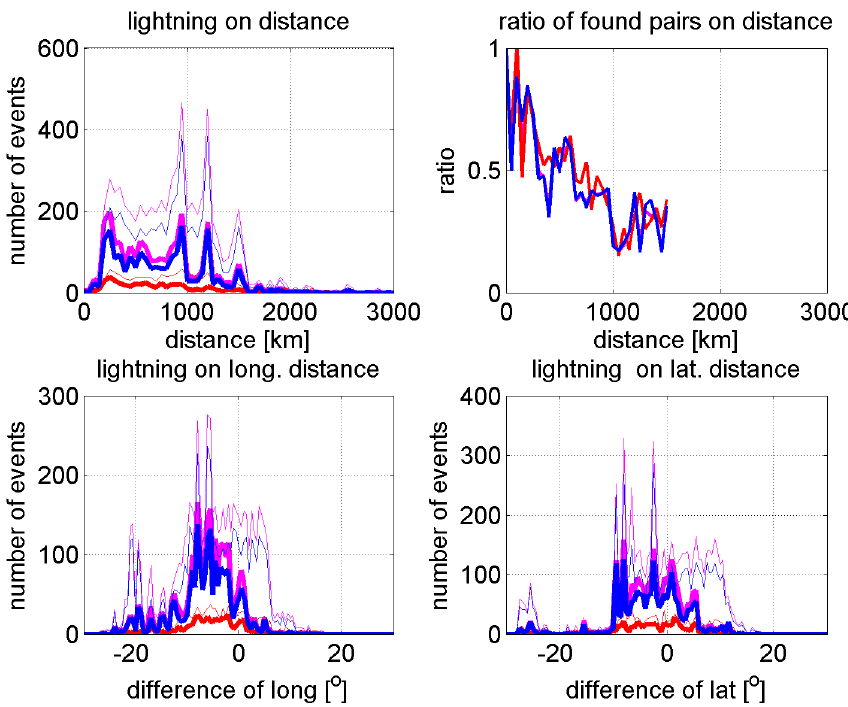
Fig. 6. Top left plot: occurrence histograms of lightning discharges on distance from the magnetic footprints of the satellites. Thick lines stand for the lightning for which the corresponding whistler was found, thin lines stand for all detected lightning. Magenta lines represent all types of discharges, blue − CG discharges, red +CG discharges. Top right plot: the ratio of lightning discharges for which the corresponding whistler was found to all discharges. Colours distinguish different types of discharges and their meaning is the same as in the top left plot. Note that the values for distances larger than ∼ 1500km are statistically insignificant – see the top left plot. Bottom: Occurrence histogram of the distances between the magnetic footprints of the satellites and lightning discharges decomposed on longitude (left) and latitude (right). The meaning of lines and colours is the same as in the top right plot. The meaning of signs is the same as in Fig.